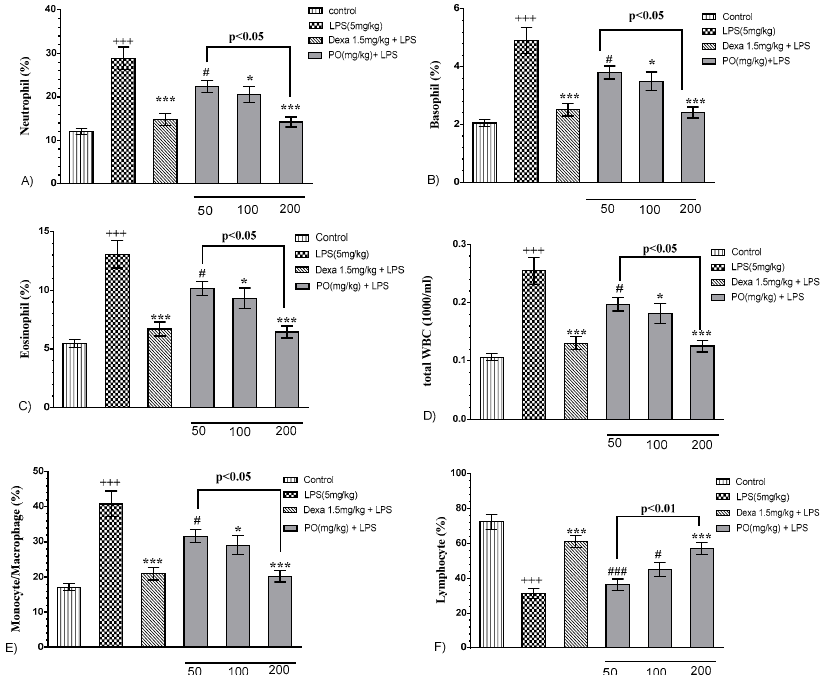
Figure 2. Effect of PO extract on hematologic indices ( A ) neutrophil, ( B ) basophil, ( C ) eosinophil, ( D ) total white blood cell, ( E ) monocyte/macrophage ratio, and ( F ) lymphocyte in BALF. Data were presented as mean ± SEM ( n = 5). +++ p ≤ 0.001 compared with the control group, * p ≤ 0.05 and *** p ≤ 0.001 compared with the LPS-induced group and # p ≤ 0.05 and ### p ≤ 0.001 compared with the Dexa + LPS group. WBC—white blood cells.